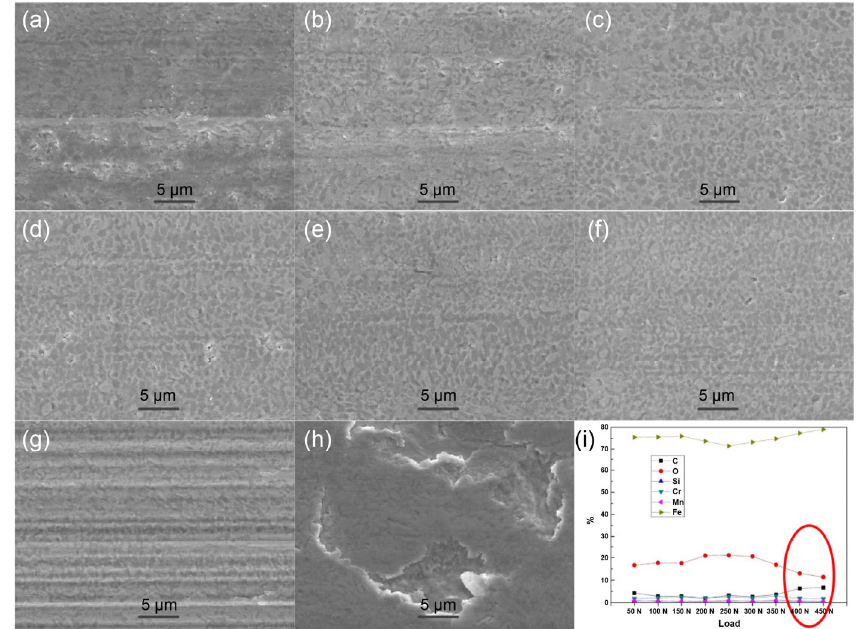
Fig. 16 Surface morphology and distribution of element in worn surface: (a) 50 N; (b) 100 N; (c) 150 N; (d) 200 N; (e) 250 N; (f) 300 N; (g) 350 N; (h) 400 N; (i) distribution of